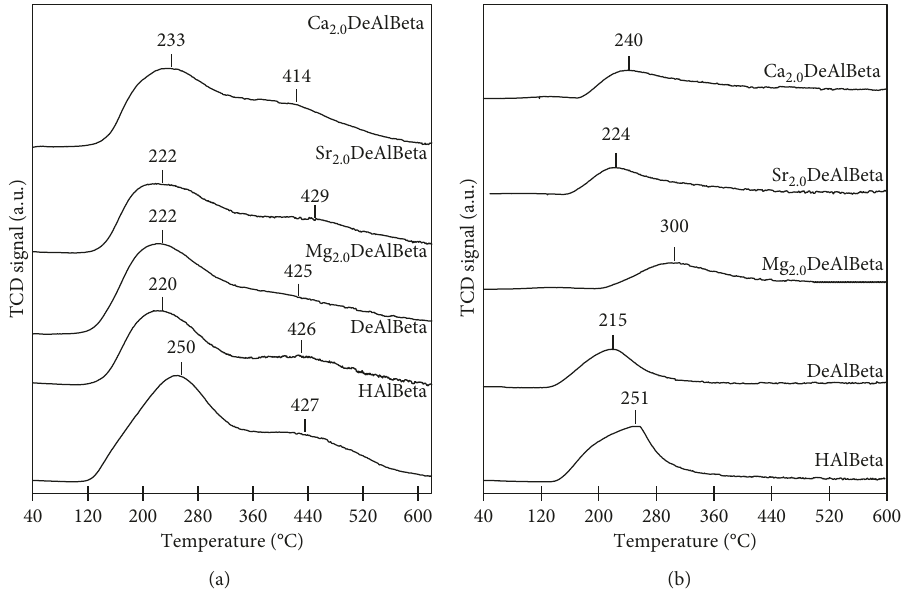
Figure 6: Temperature-programmed desorption profiles of ammonia (a) and carbon dioxide (b) for HAlBeta, DeAlBeta, Mg Sr 2.0 DeAlBeta, and Ca 2.0 DeAlBeta samples. Table 2: Surface quantitative analysis of TPD-NH measurements on HAlBeta, DeAlBeta, Sr 2.0 DeAlBeta, Ca 2.0 DeAl- Beta, and Mg 2.0 DeAlBeta.